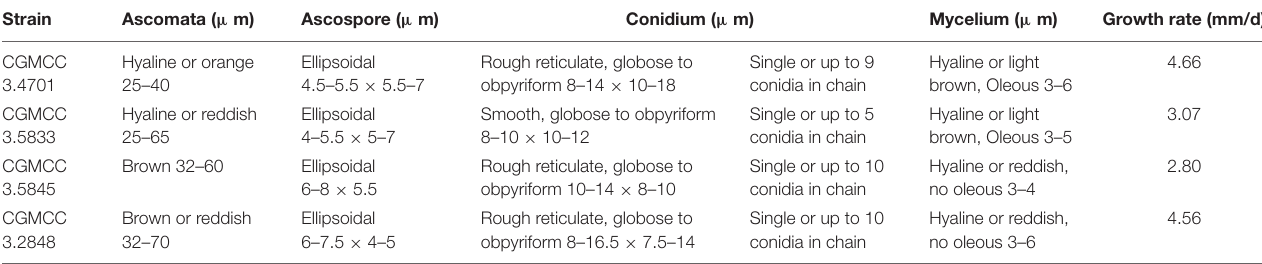
TABLE 2 | Morphological characteristics of some tested strains of Monascus